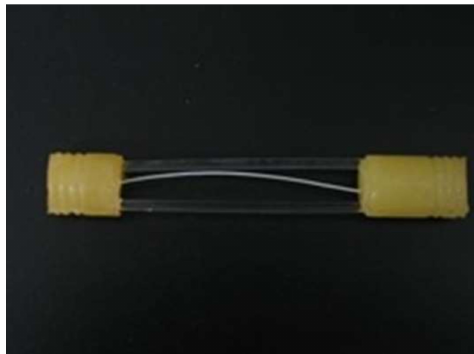
Figure 4. Photograph of a hollow fiber membrane module prepared in this